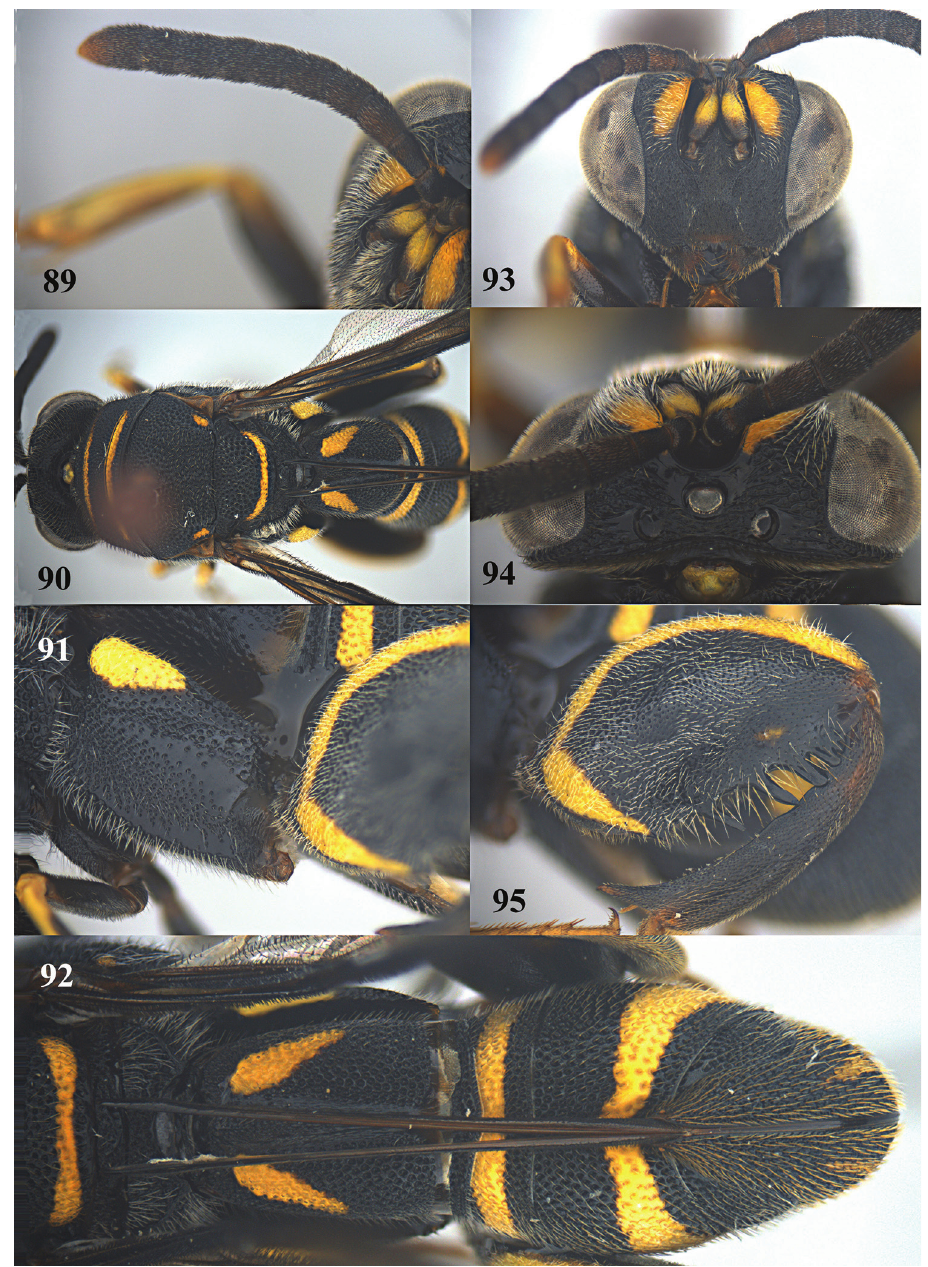
Figures 89–95. Leucospis histrio Maindron, ♀ from Guangdong, Guangyinshan. 89 Antenna 90 meso- soma dorsal 91 hind coxa 92 metasoma dorsal 93 head frontal 94 head dorsal 95 hind femur and